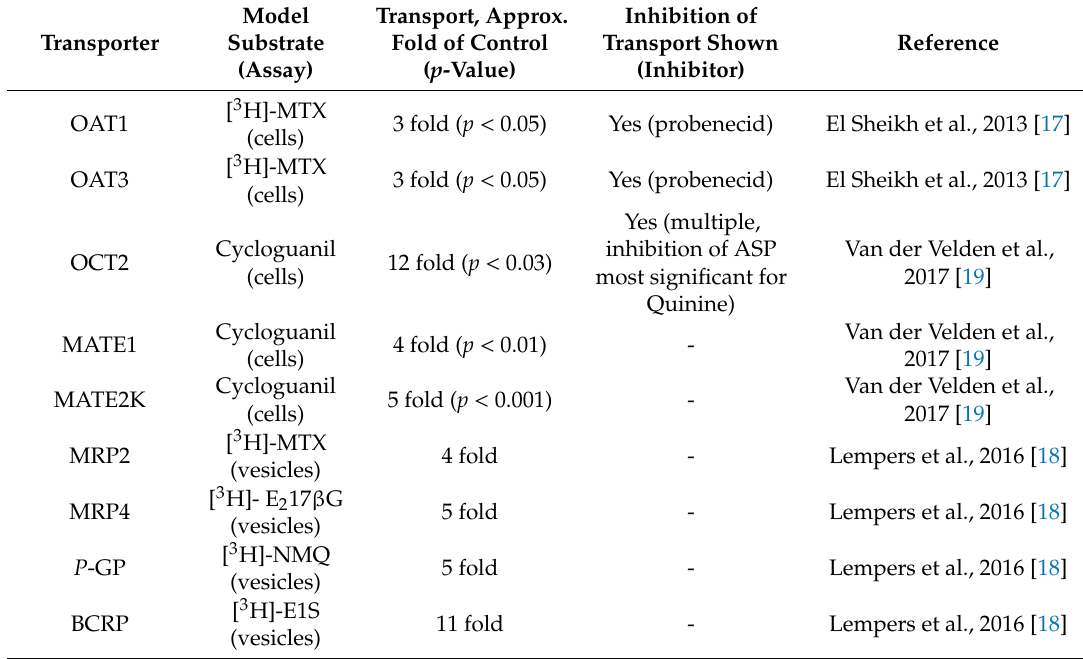
Table 1. Previously described transporter activity for listed transporters. Fold change for cellular assay calculated by transport observed in cells transduced with transporter of interest divided by transport observed in cells transduced with EYFP. Fold change for vesicular assay calculated as transport observed in vesicles with ATP divided by those with